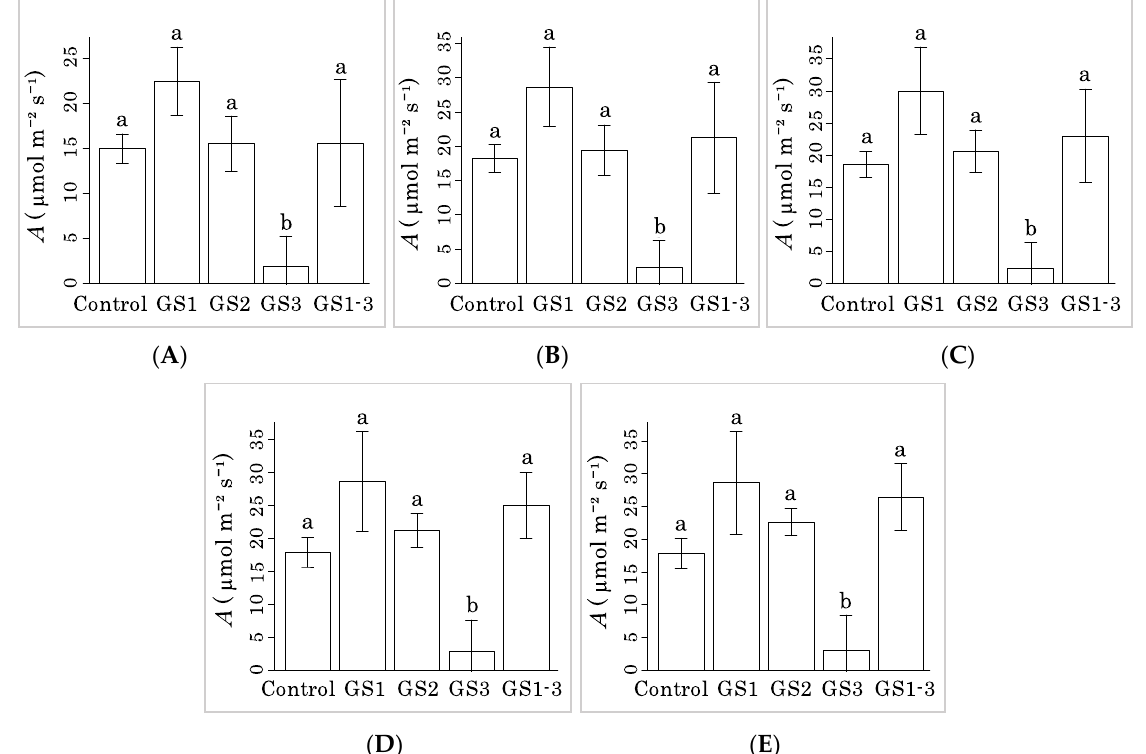
Figure 8. Carbon assimilation rate at CO 2 concentrations of ( A ) 500 ppm, ( B ) 800 ppm, ( C ) 1000 ppm, ( D ) 1500 ppm, and ( E ) 2000 ppm. Letters on the bars with the same alphabet indicate not significant difference by Tukey’s range test ( p < 0.05).